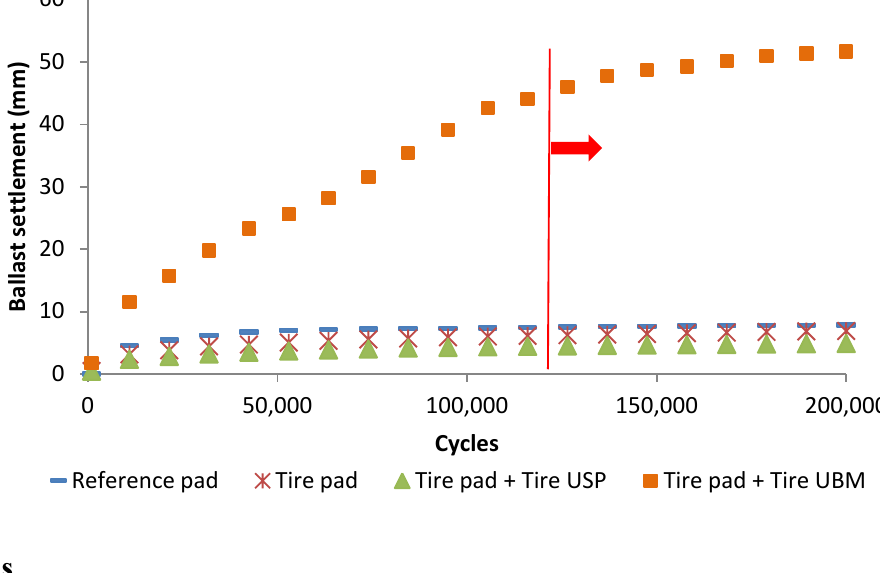
Figure 11. Evolution of the ballast settlement depending on the tire elements